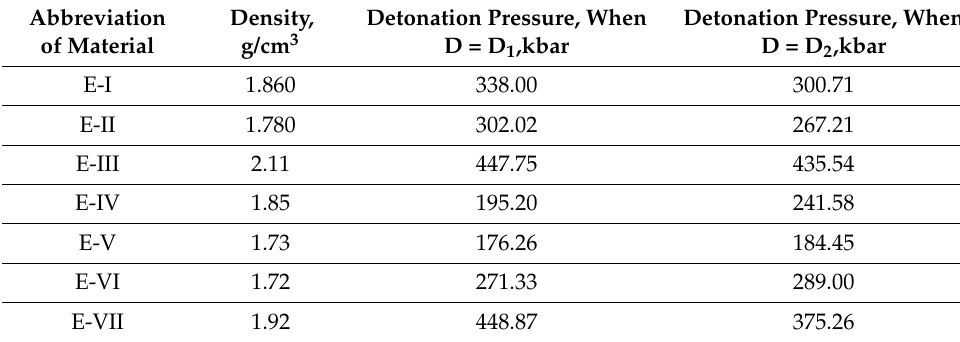
Table 4. Detonation pressure of the compounds